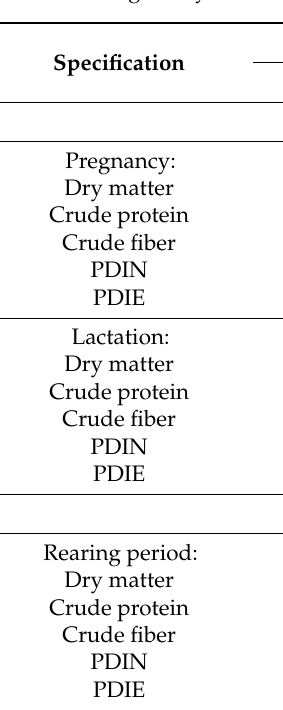
Table 2. Average daily nutrient intake in groups